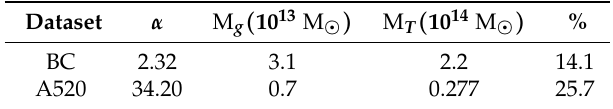
Table 3. Summary of results for the Bullet Cluster and the two datasets for